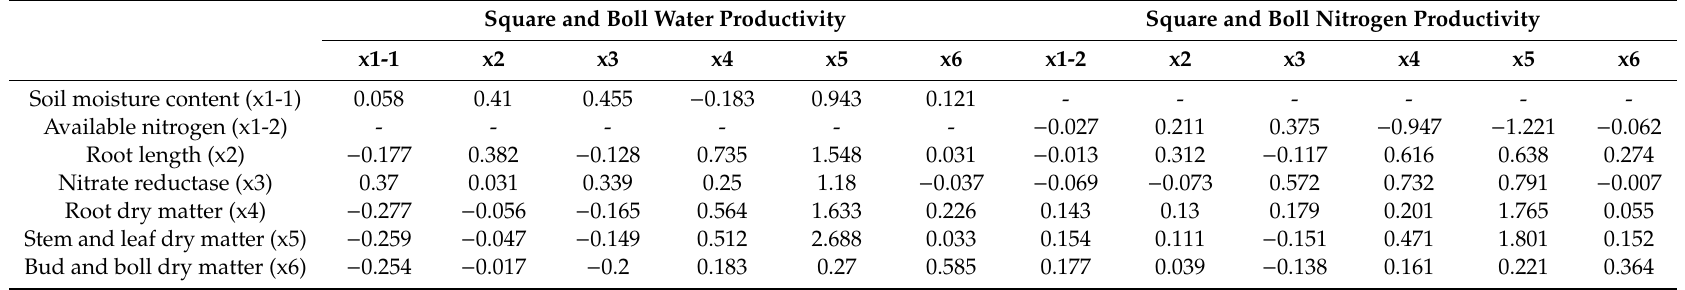
Table 5. Path analysis ( n = 60) for the direct or indirect e ff ect on square and boll water-nitrogen productivity by soil moisture content, available nitrogen (mg kg − 1